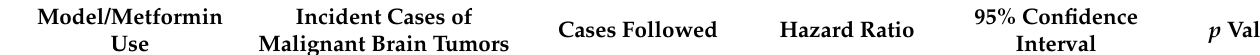
Table 3. Sensitivity